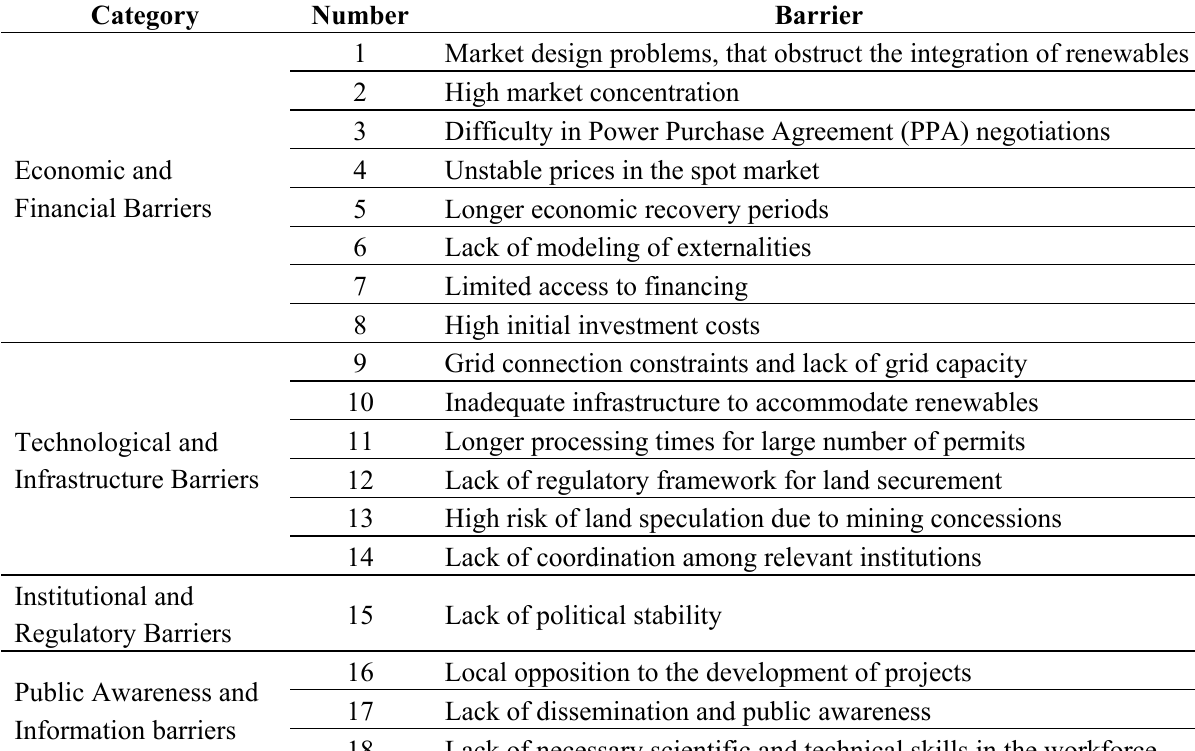
Table 2. Selected barriers to the advancement of renewable energy in